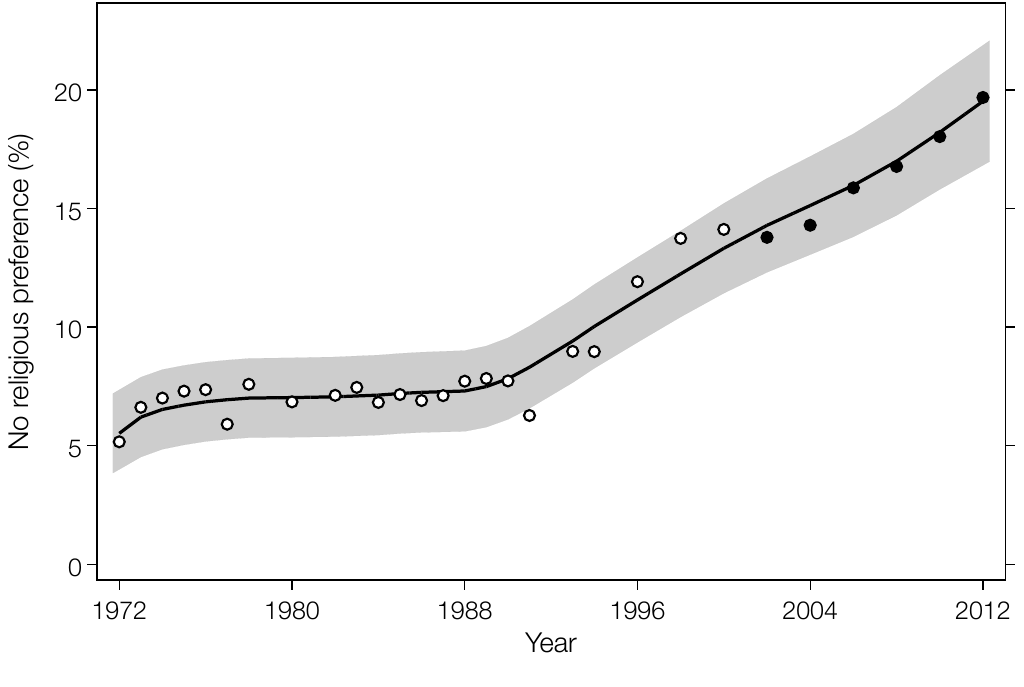
Figure 1: No Religious Preference (percent) by Year: Adults, United States, 1972–2012. Notes: The line shows data smoothed by locally estimated (loess) regression with a bandwidth of 0.4; white circles show observed percentages through 2000; black circles show observed percentages 2002-2012; gray area shows the 95 percent confidence intervals for the full probability samples and an approximate confidence interval for the 1972 quota sample. The confidence intervals are centered on the smoothed data to aid interpretation. Source: Authors’ calculations from General Social Surveys (Smith et al.